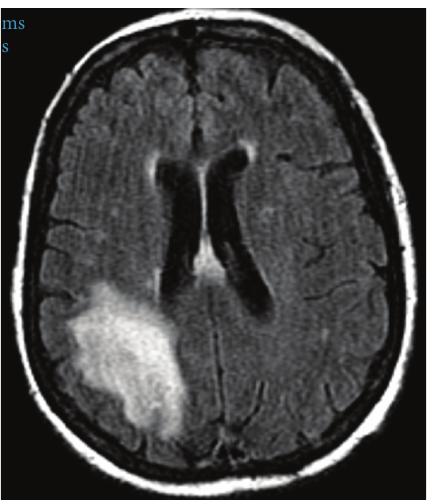
Figure 1: Axial T2-FLAIR image shows increase in signal intensity in the subcortical white matter involving the U-fibers in the right parietal